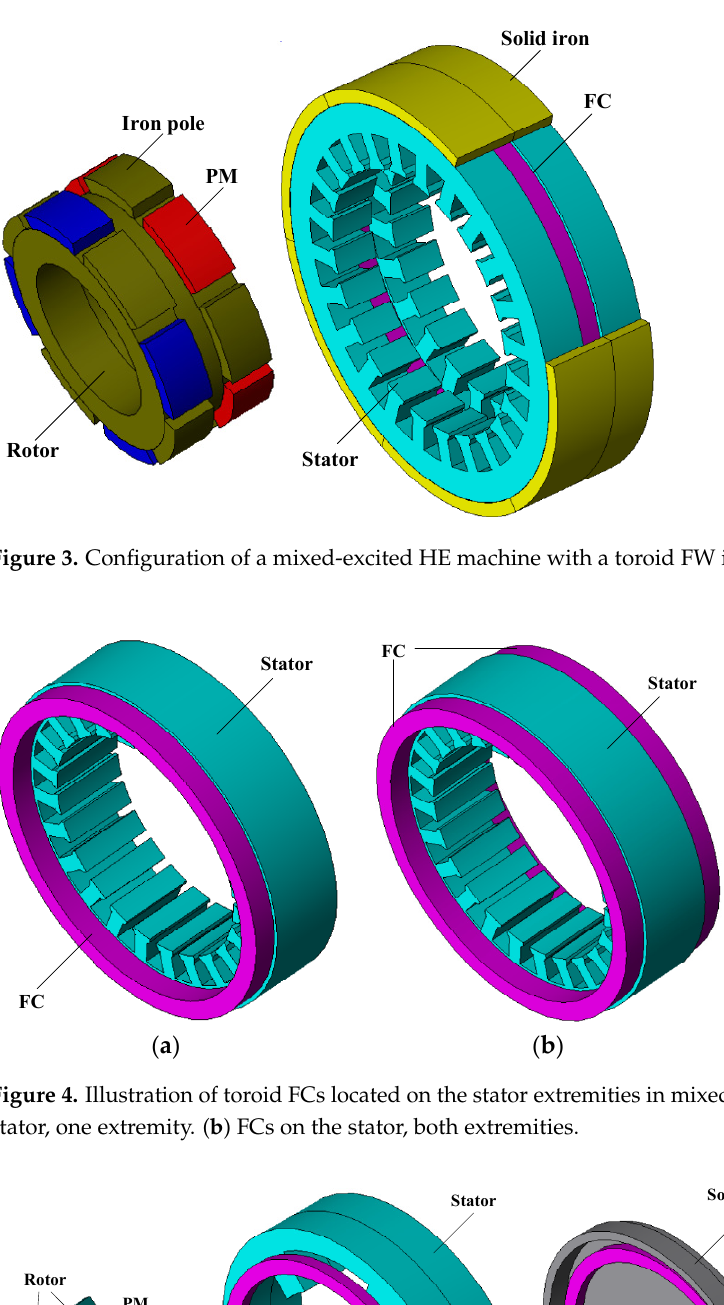
Figure 5. Configuration of the mixed ‐ excited HE machine with skewed dual ‐ stack rotor [34].